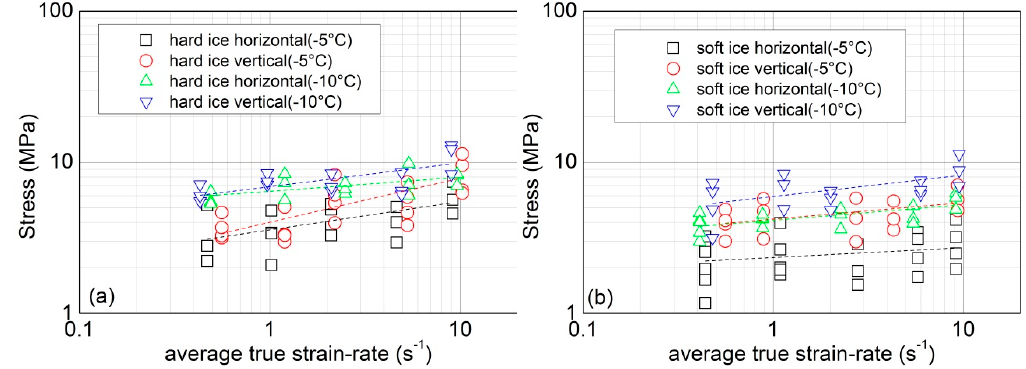
Figure 17. Uniaxial compressive strength results at moderate strain rates: ( a ) hard ice; and ( b ) soft ice.